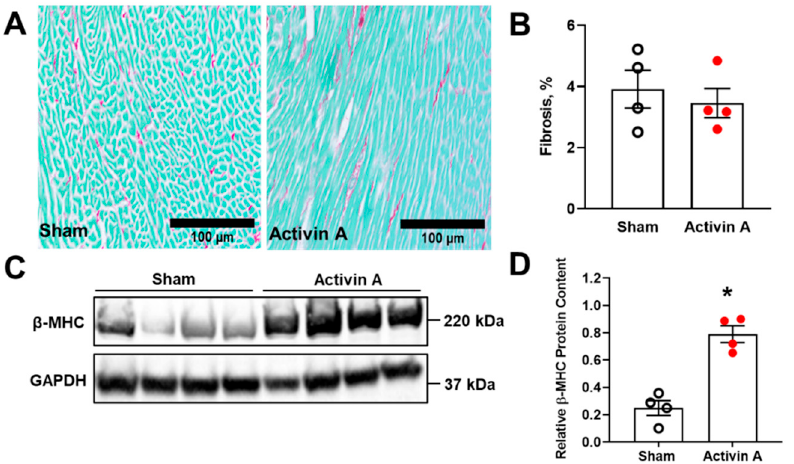
Figure 5. Markers of cardiac injury. Left ventricular fibrosis ( A , B ) indicated by Sirius Red and Fast Green staining, and beta-cardiac myosin heavy chain ( β -MHC) protein content ( C , D ) on gestational day 19 in sham (open black circles) and activin A-infused (6 µ g/day; solid red circles) pregnant rats. Data are mean ± SEM, * p < 0.05 vs.